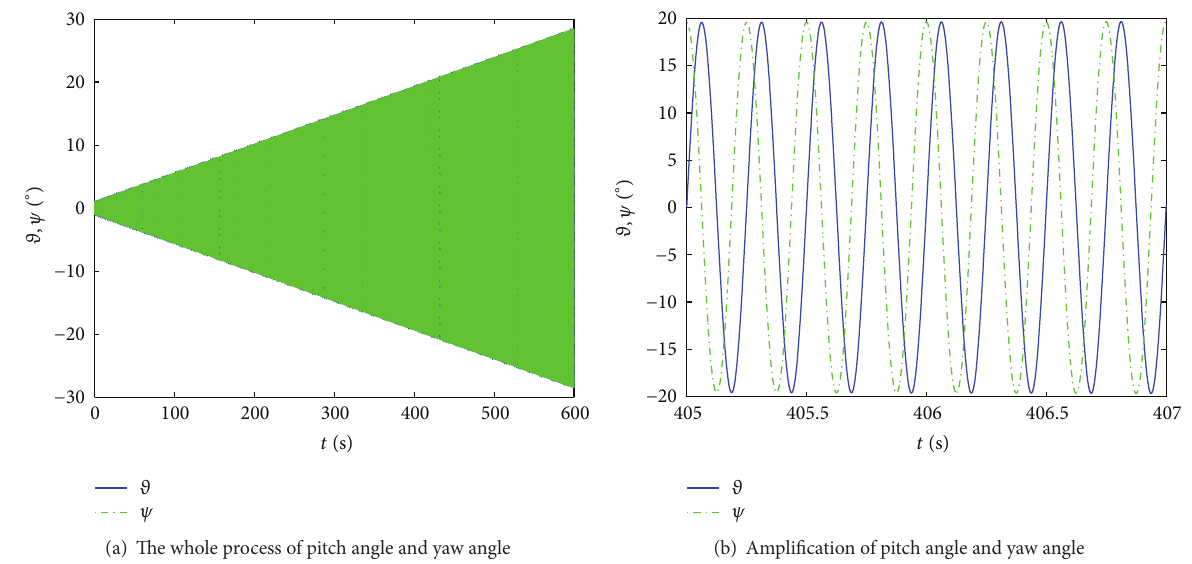
Figure 8: Pitch angle and yaw angle of the